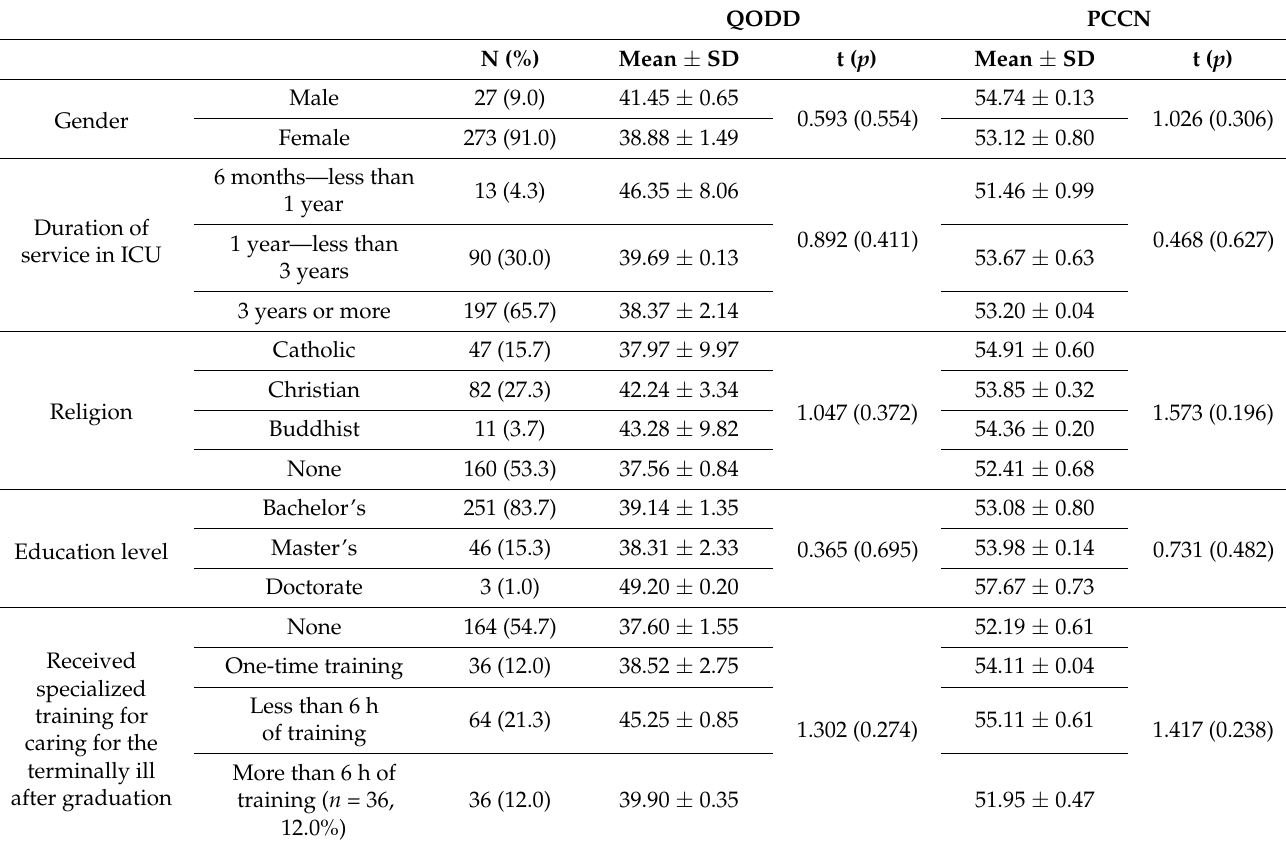
Table 3. QODD and PCCN, according to the general characteristics of nurses (N = 300).